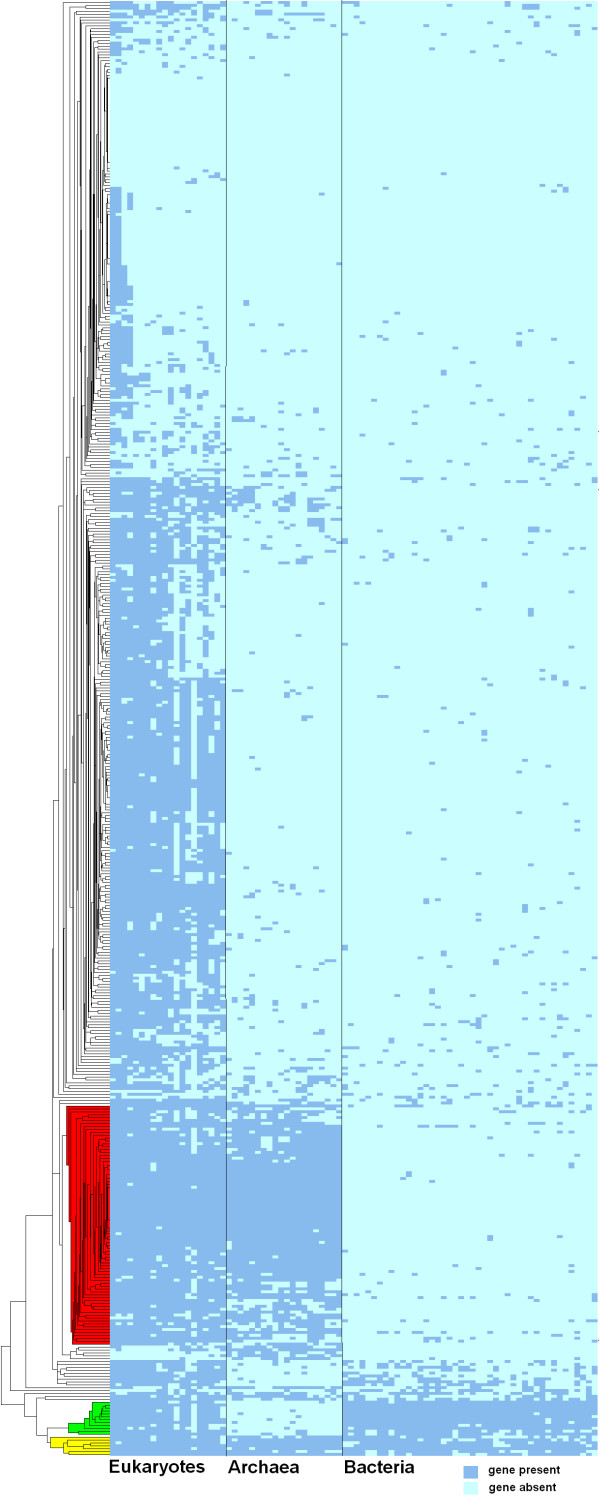
Hierarchical clustering of phylogenetic profiles of nucleolar proteins. Phylogenetic profiles of all 501 nucleolar or ribosome-associated proteins. Organisms vary along the horizontal axis, proteins along the vertical axis. Presence of a gene is indicated by dark blue, absence by light blue. Organisms from the three domains of life are separated by black bars. The dendrogram resulting from protein-wise hierarchical clustering is given on the left. Several evolutionarily meaningful clusters emerged, which are colored in the dendrogram: red, proteins of archaeal origin; yellow, ubiquitous proteins; green, proteins of (eu-)bacterial origin. Note that the eukaryote-only genes constitute the largest group, followed by the archaea/eukaryote group. There is a considerable number of genes with orthologs only in bacteria and eukaryota, but not in archaea.